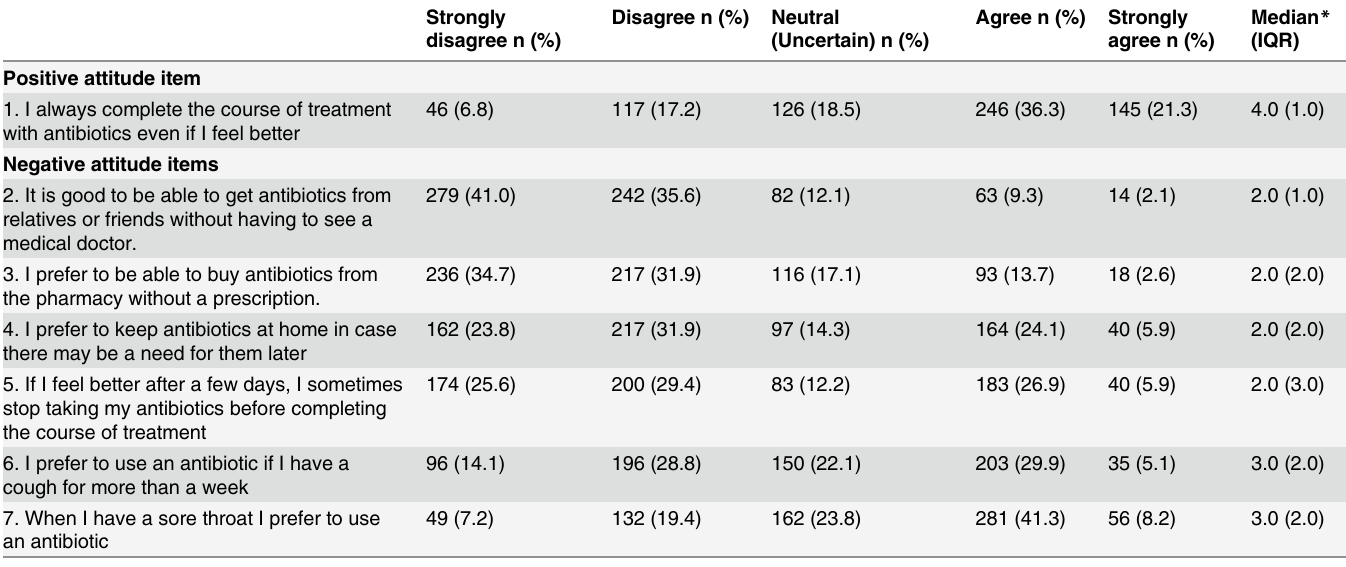
Table 3. Respondents ’ Attitudes towards Use of Antibiotics (n = 680).